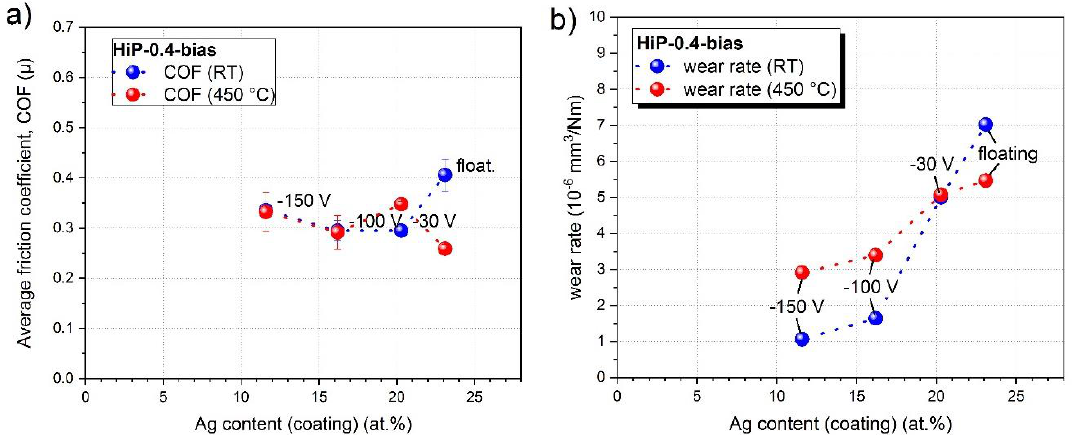
Figure 15. COFs ( a ) and wear rates ( b ) vs. Ag content of the samples from the bias series (HiP-0.4-bias) of pin-on-disc tests at RT and HT (450 °C, 5000 rotations).